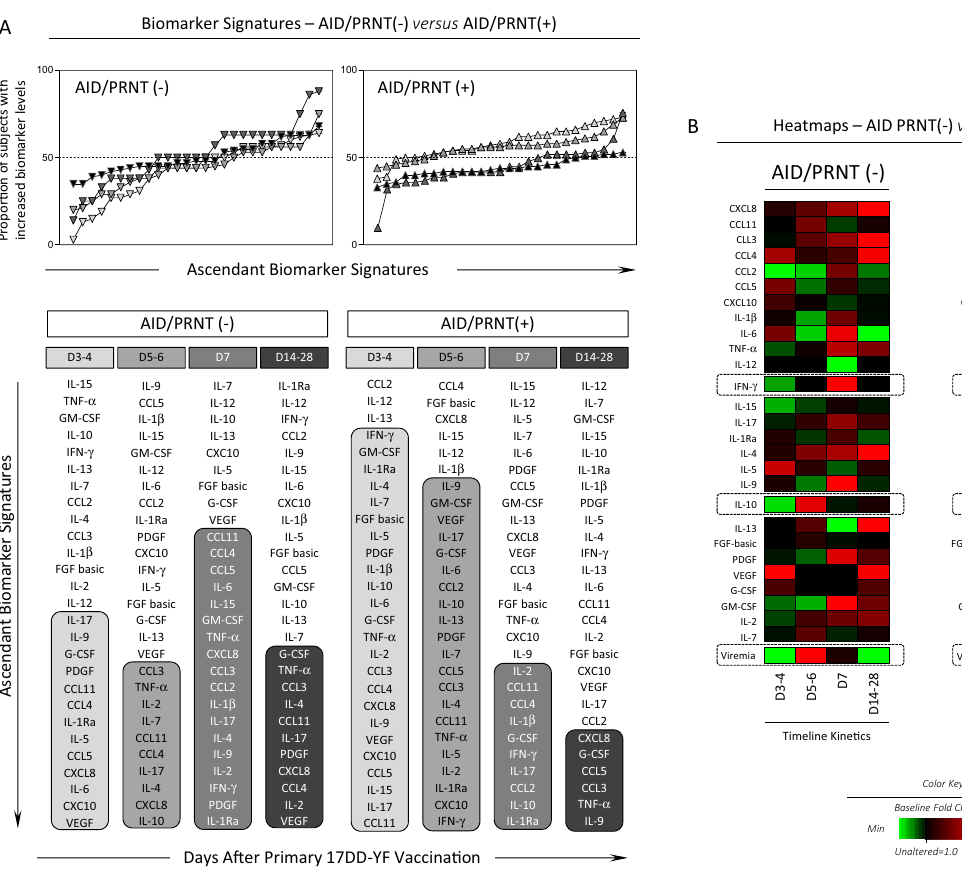
Figure 6. Serum Biomarker Signatures in Patients with Autoimmune Disease According to the Neutralizing Antibody Status After Planned Primary 17DD-YF Vaccination. ( A ) Kinetics of serum biomarker signatures at distinct time points after primary 17DD-YF vaccination of Autoimmune Disease patients categorized according to the PRNT status after primary 17DD-YF vaccination: AID/PRNT(−) (n = 32, D3–4 = light grey filled inverted triangle, D5–6 = grey filled inverted triangle, D7 = dark grey filled inverted triangle and D14– 28 = black filled inverted triangle) and AID/PRNT(+) (n = 108, D3–4 = light grey filled triangle, D5–6 = grey filled triangle, D7 = dark grey filled triangle and D14–28 = black filled triangle). The results are expressed as the proportion of subjects with increased biomarker levels (baseline fold change values > 1). Data analysis was carried out considering the 50th percentile as the reference to identify the set of biomarkers with high proportion of subjects with levels above the global median cut-off along the kinetic timeline. Those biomarkers with proportion of subjects with levels above the global median cut-off were highlighted with gray scale rectangles. ( B ) Heatmaps were assembled for subgroups of Autoimmune Disease patients considering the PRNT status after vaccination [AID/PRNT(−), n = 32; AID/PRNT(+), n = 108] and according to the type of autoimmune disease [Rheumatoid Arthritis (RA, n = 38), Spondyloarthritis (SpA, n = 51), Systemic Lupus Erythematosus (SLE, n = 21) and Sjögren’s Syndrome (SS, n = 30)]. Data interpretation was carried out based on the color keys employed to underscore the baseline fold value = 1.0 as the reference for unaltered levels (black filled square), the baseline fold value < 1.0 for decreased levels (green filled square) and the baseline fold value > 1.0 for increased levels (red filled square), according to the paired sample collected at